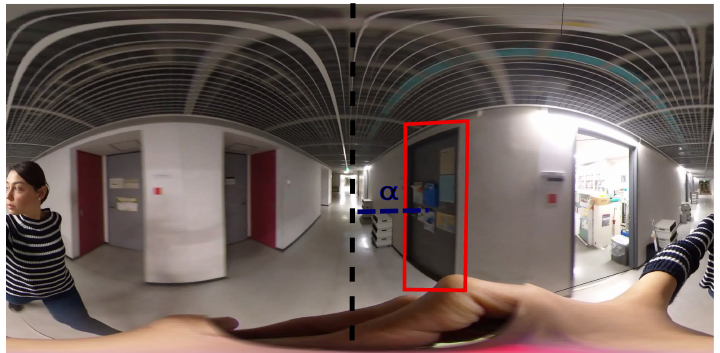
Figure 2. Example for visual input: The camera is held by the user. The middle of the equirectangular image is considered to be zero. The sample predetermined object class “door” has a detection result in the bounding